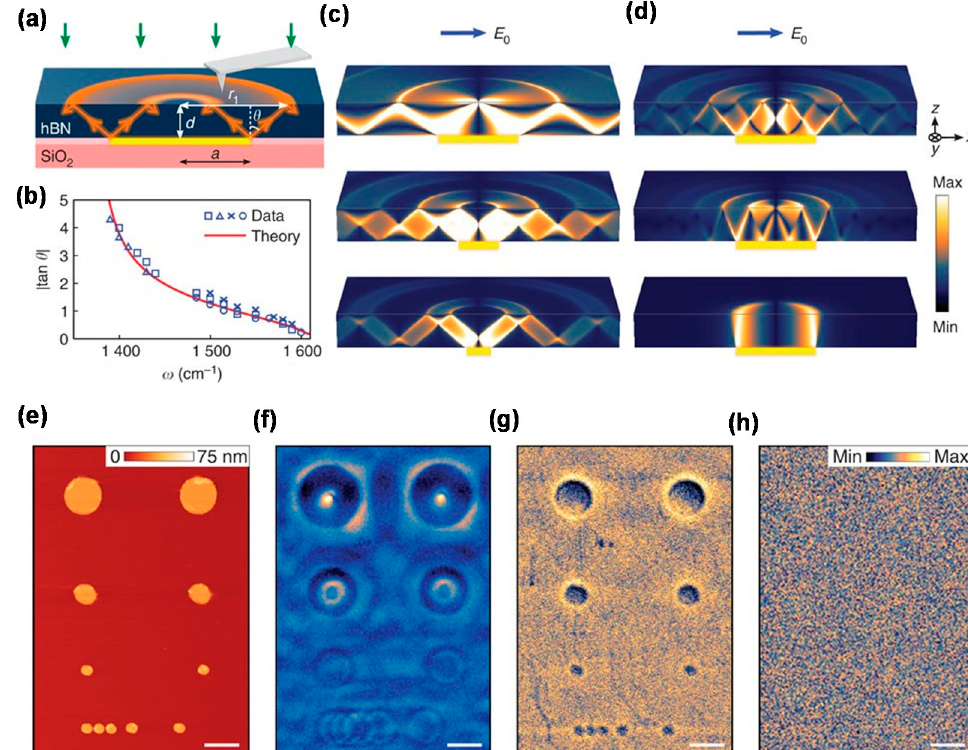
Figure 11. ( a ) Concept of a hBN-based hyperlens. The yellow rectangle shows the Au disk. ( b ) |tan θ | as a function of frequency. ( c , d ) Electric field distribution in the z direction with ( c ) a / d = 0.5 (top), 0.25 (middle), and 0.15 (bottom) and ( d ) a / d = 1.12 and |tan θ | = 0.75 (top), 0.375 (middle), and 0.01 (bottom). ( e ) Atomic force microscopy (AFM) image of Au disks. Scattering-type scanning near-field optical microscopy (s-SNOM) images at infrared (IR) laser frequencies ω of ( f ) 1515 cm − 1 ( λ = 6.6 μ m), ( g ) 1610 cm − 1 ( λ = 6.2 μ m), and ( h ) 1740 cm − 1 ( λ = 5.7 μ m). Figures were adapted from [29] under CC BY 4.0.